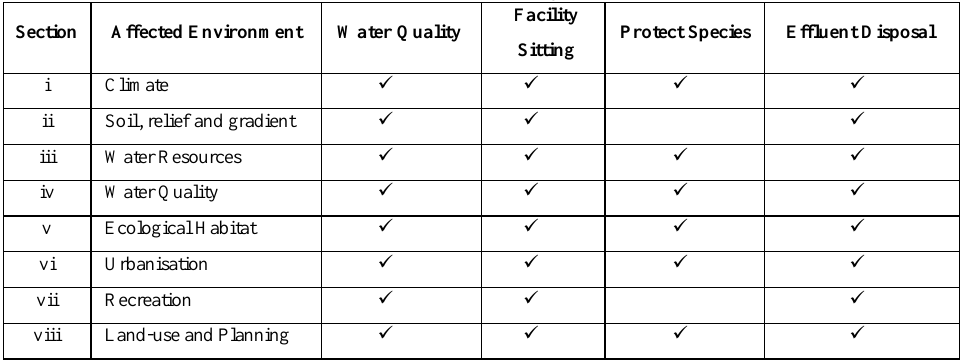
Table 1: Pollution sources and pollution